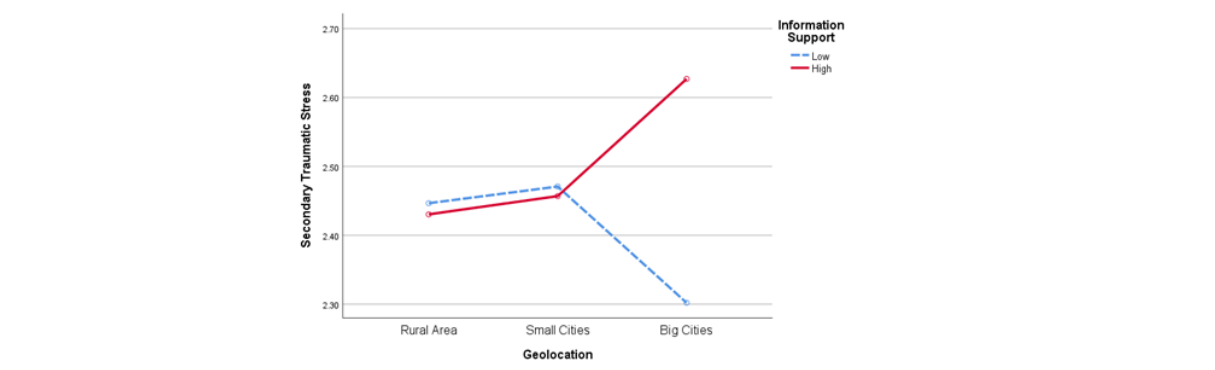
Figure 3. Interaction between geolocation and information support for secondary traumatic stress.